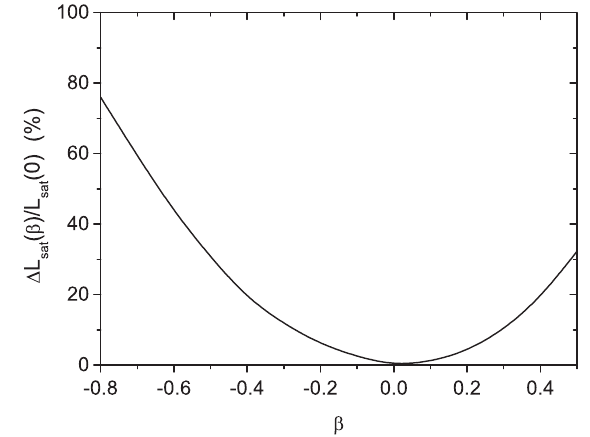
FIG. 3. Relative increase of the saturation length (defined as a length of the undulator at which maximum bunching is achieved) versus taper strength parameter. Energy spread parameter is ^(cid:2) ¼ 0 : 2 . T